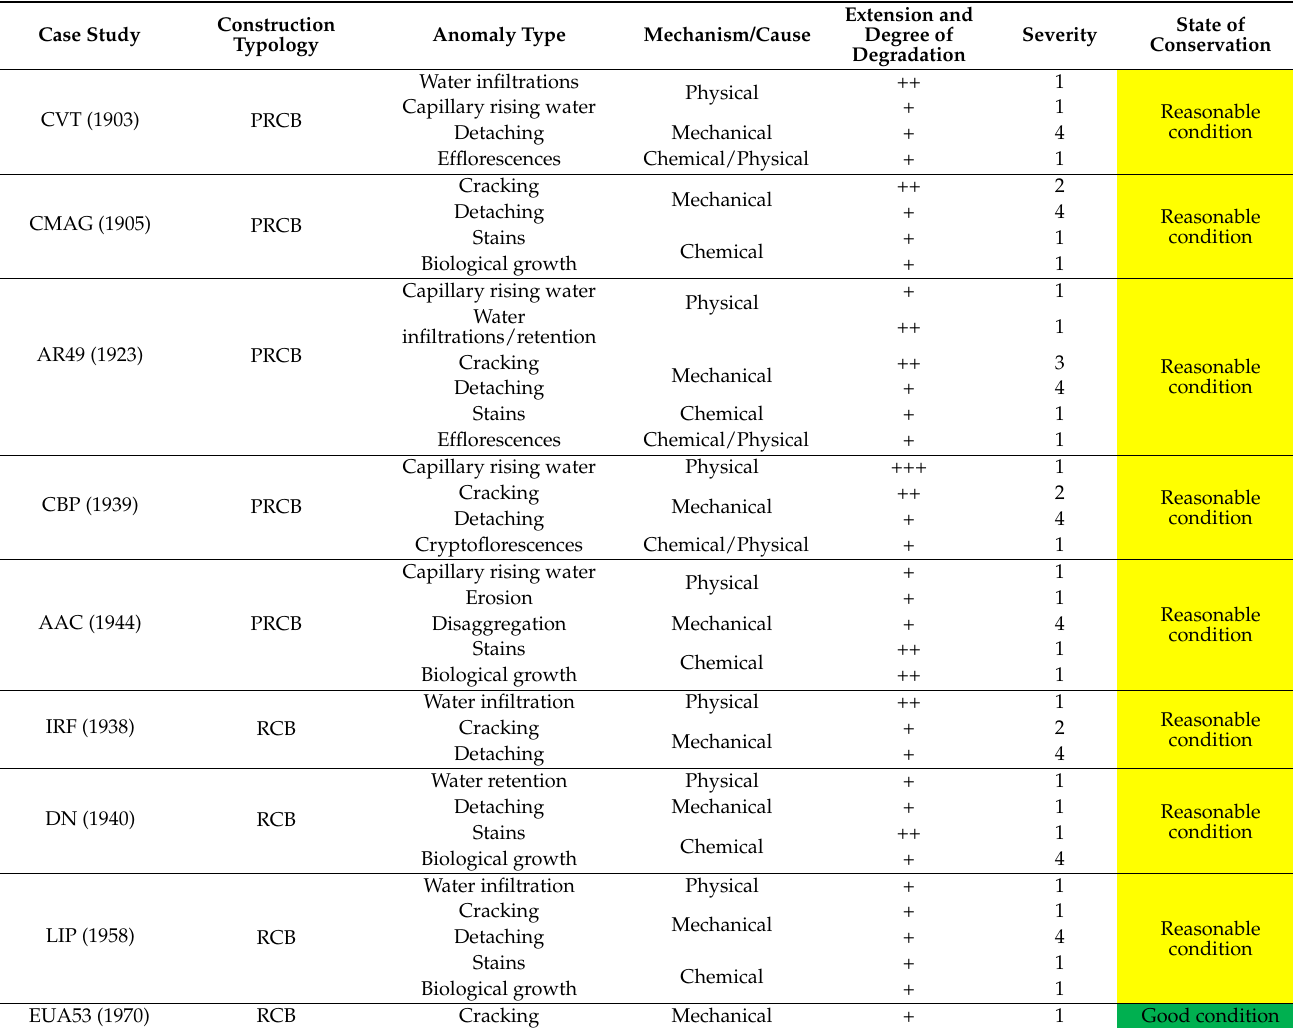
Table 8. State of conservation classification of renders and plasters in Lisbon’s awarded buildings (colour code according to Table 4). Case